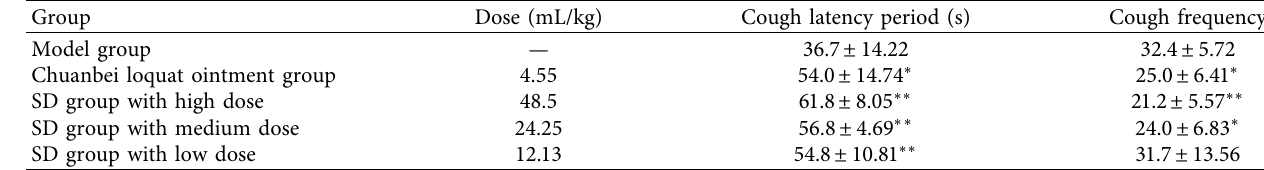
Table 8: Effect of SD on mice with cough induced by ammonia ( x ± s , n � 10).